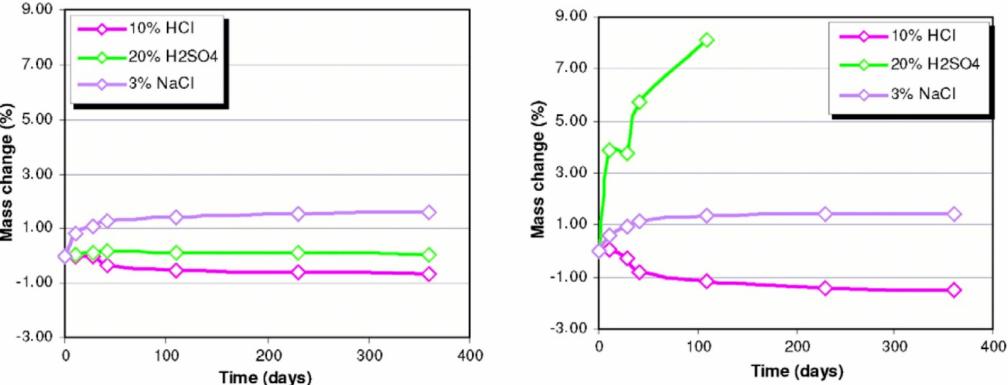
Figure 6. Apparent porosity in di ff erent sulfur concrete specimens [27]. “Reproduced with